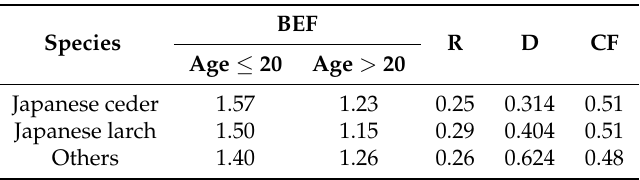
Table 3. Parameters used for calculating carbon